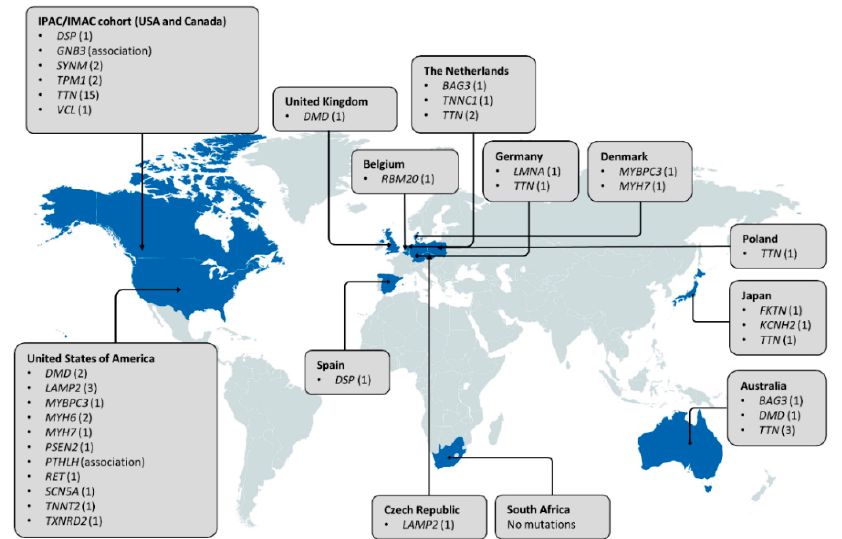
Figure 4. Distribution of genes associated with PPCM to date. Countries in which genetic investi- gations of PPCM patient(s) have been conducted are indicated in blue. The number of pathogenic mutations identified in each gene is indicated in parentheses. Three pathogenic MYH7 mutations and seven SCN5A mutations are not included as the countries of origin could not be determined.